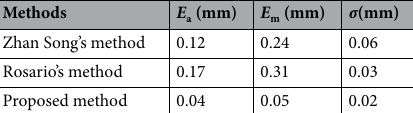
Table 2. The errors of the reconstructed plane with different